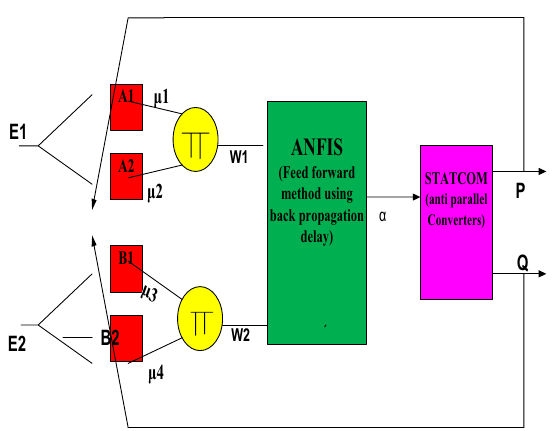
Fig. 18 Closed loop ANFIS structure